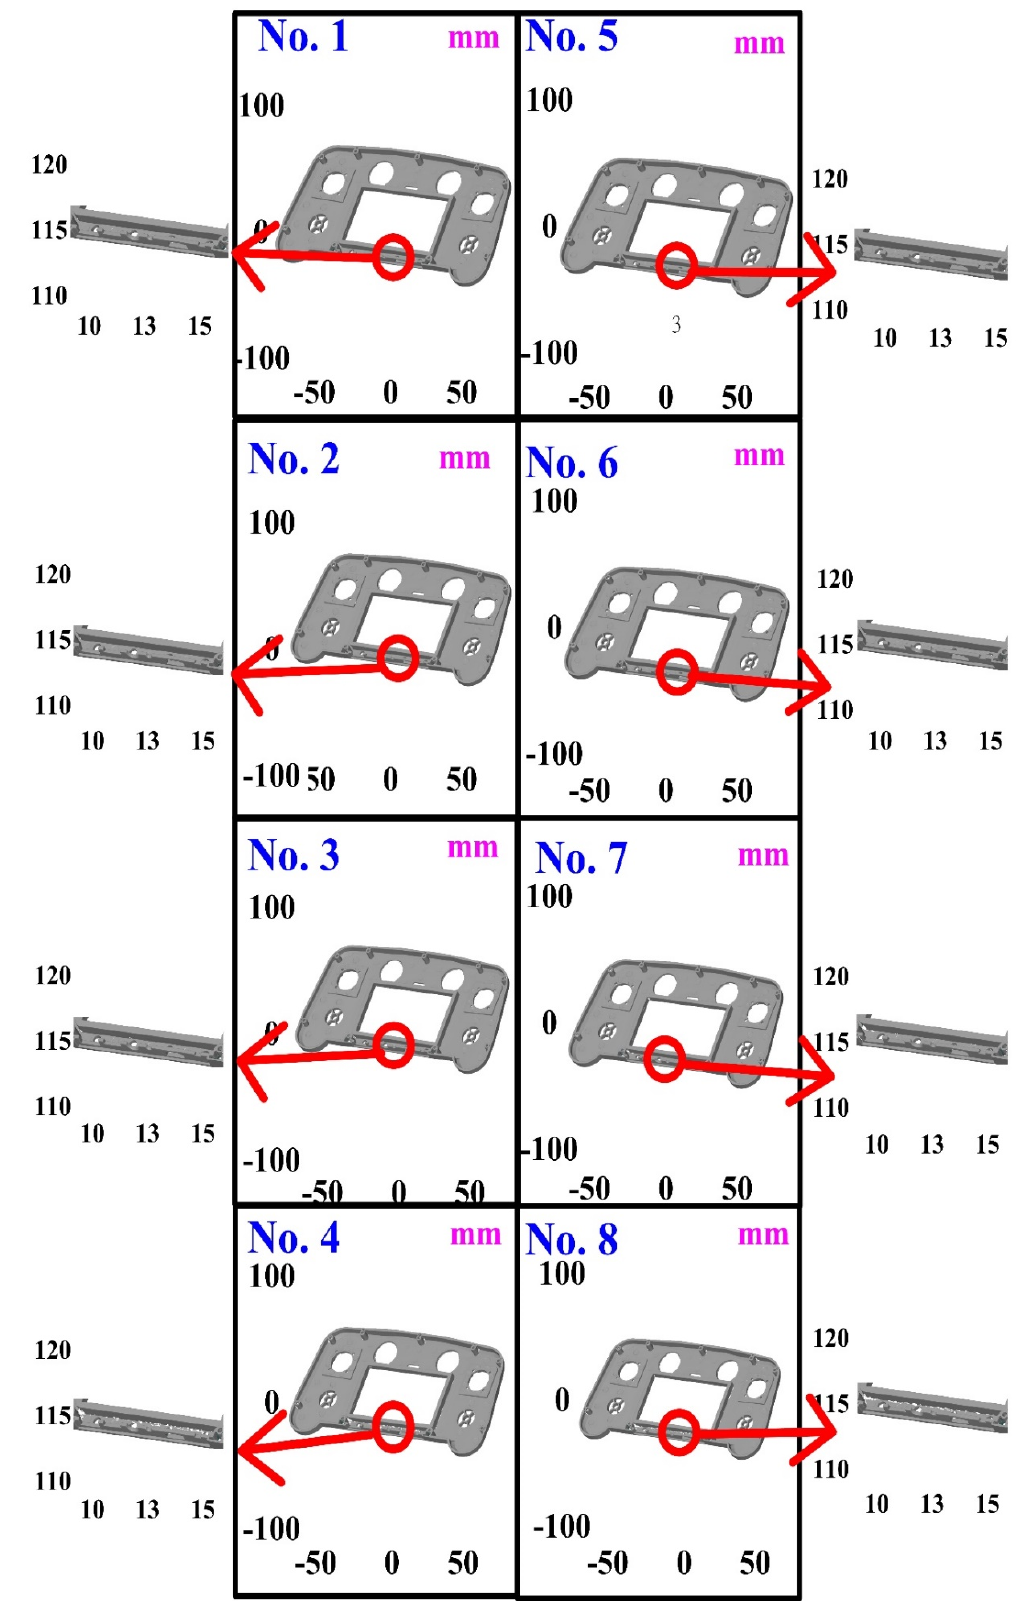
Figure 6. Measurement results of light-colored plastic part without sprayed mixture of TiO 2 powder and ethanol.